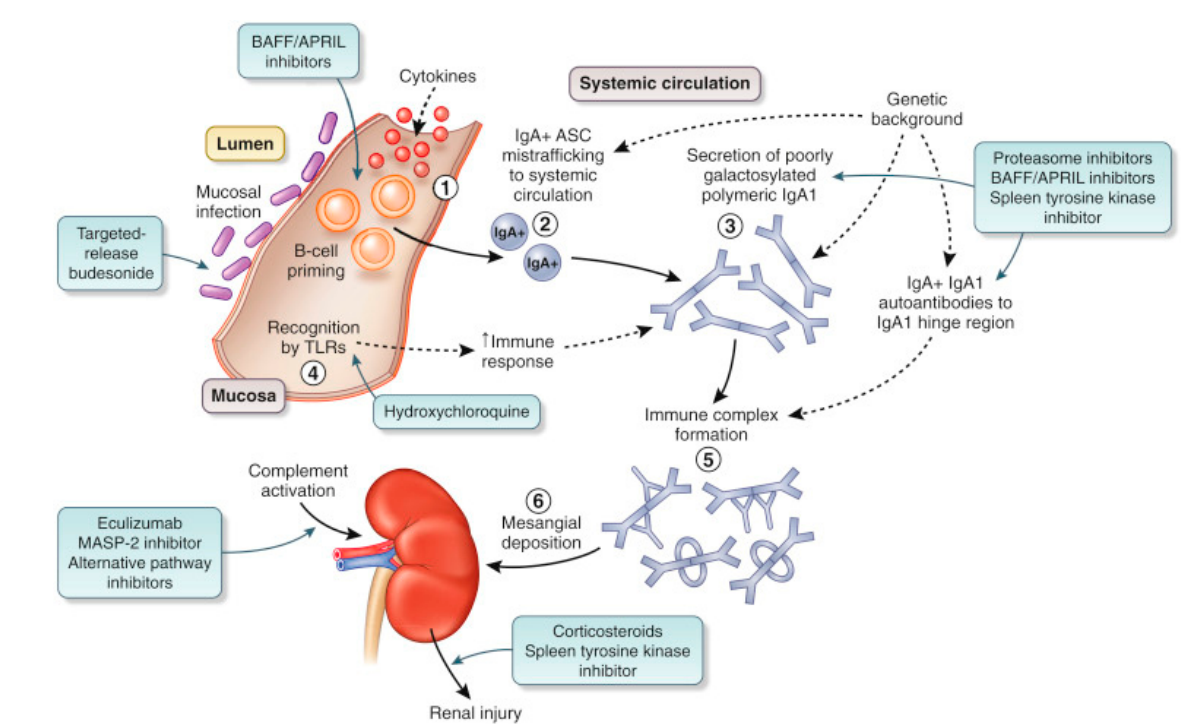
Figure 1. Proposed pathogenesis of IgAN and novel treatment strategies. ( 1 ) Mucosal infection primes naïve B cells to class switch to become IgA + antibody secreting cells (ASCs) through T cell-dependent (cytokine mediated) and T cell- independent (Toll-like receptor (TLR) ligation) pathways. ( 2 ) Some IgA + ASC mis-home to the systemic compartment during lymphocyte trafficking. ( 3 ) Displaced IgA + ASCs take up residence in systemic sites and secrete normal ‘mucosal-type’ poorly galactosylated (galactose deficient) and polymeric IgA1 into the systemic circulation. ( 4 ) IgA1 secretion by displaced mucosal ASC is augmented by TLR ligation from mucosal-derived pathogen-associated molecular patterns, which have entered the systemic compartment. ( 5 ) IgA1 immune complexes form in the systemic circulation. Poorly galactosylated polymeric IgA1 molecules are the substrate for immune complex formation and combine with IgG and IgA autoantibodies reactive to exposed neoepitopes in the poorly galactosylated IgA1 hinge region. ( 6 ) IgA1 immune complexes deposit in the mesangium through a combination of mesangial trapping and increased affinity of poorly galactosylated IgA1 for extracellular matrix components. Immune complex deposition triggers a series of downstream pathways leading to glomerular injury and tubulointerstitial scarring. APRIL, a proliferation-inducing ligand; BAFF, B cell activating factor; MASP-2, mannan-binding lectin-associated serine protease-2. Reprinted from ref. [10], with permission from